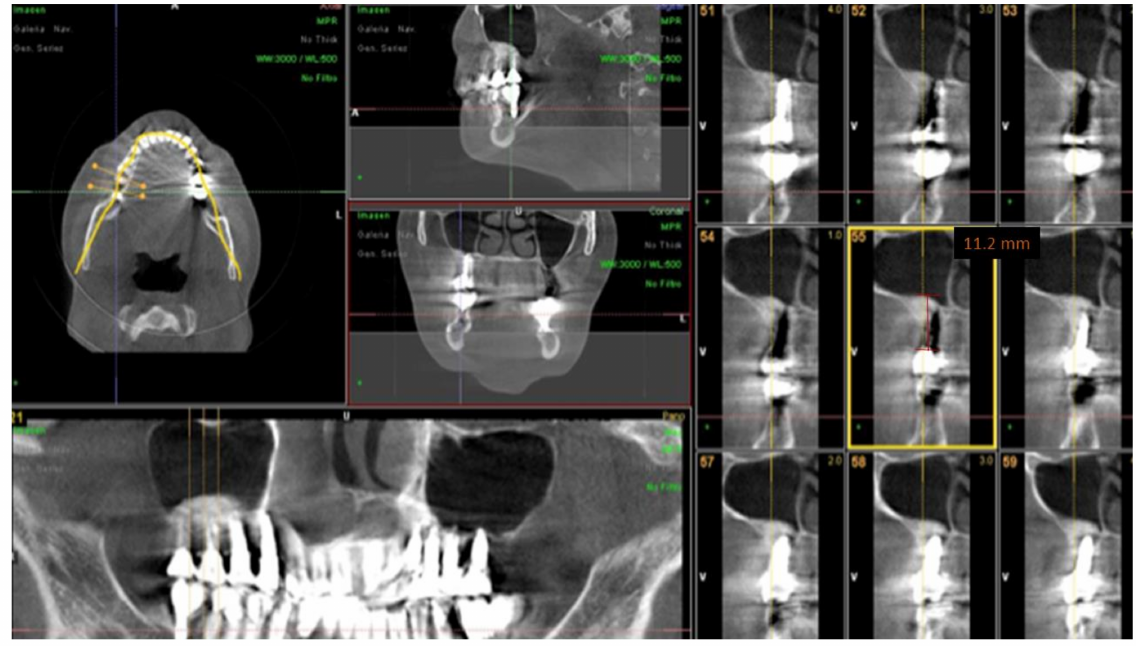
Figure 4. CBCT after maxillary sinus elevation surgery and prosthodontic